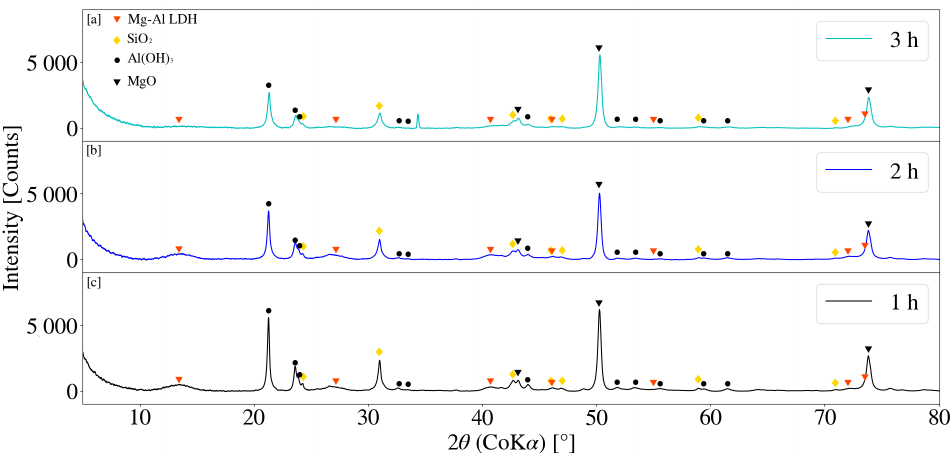
Figure 10. ( a ) X-ray diffraction pattern for Mg-Al LDH sample synthesised for a residence time of 3 h (S6). ( b ) X-ray diffraction pattern for Mg-Al LDH sample synthesised for a residence time of 2 h (S5). ( c ) X-ray diffraction pattern for Mg-Al LDH sample synthesised for a residence time of 1 h (S4). Milling parameters were set at a rotational speed of 2000 rpm, jacket water inlet temperature of 30 °C, media size of 2 mm and a solids loading of